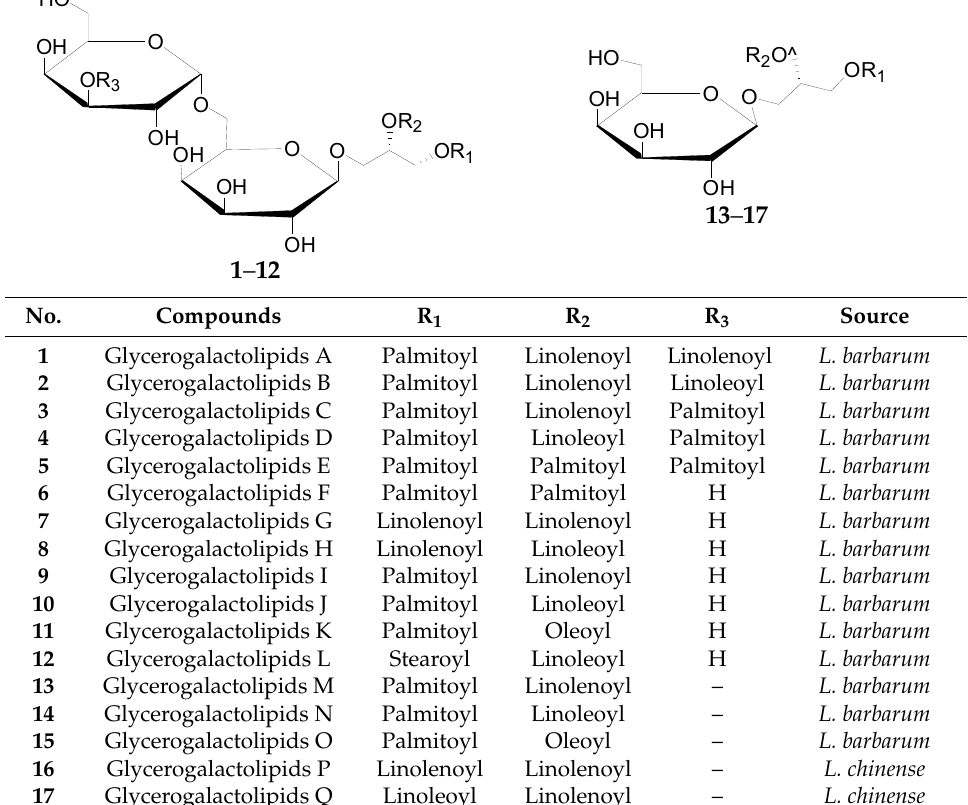
Table 2. Chemical structures of compounds 1 – 17 .